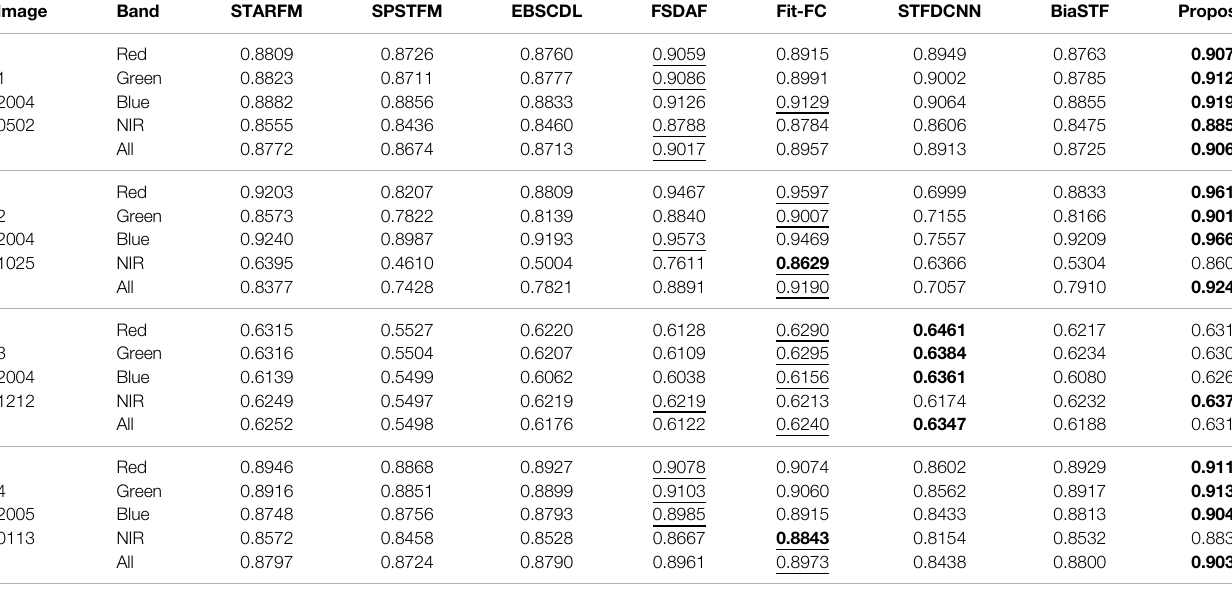
TABLE 5 | SSIM evaluation of radiometric error for the LGC dataset.